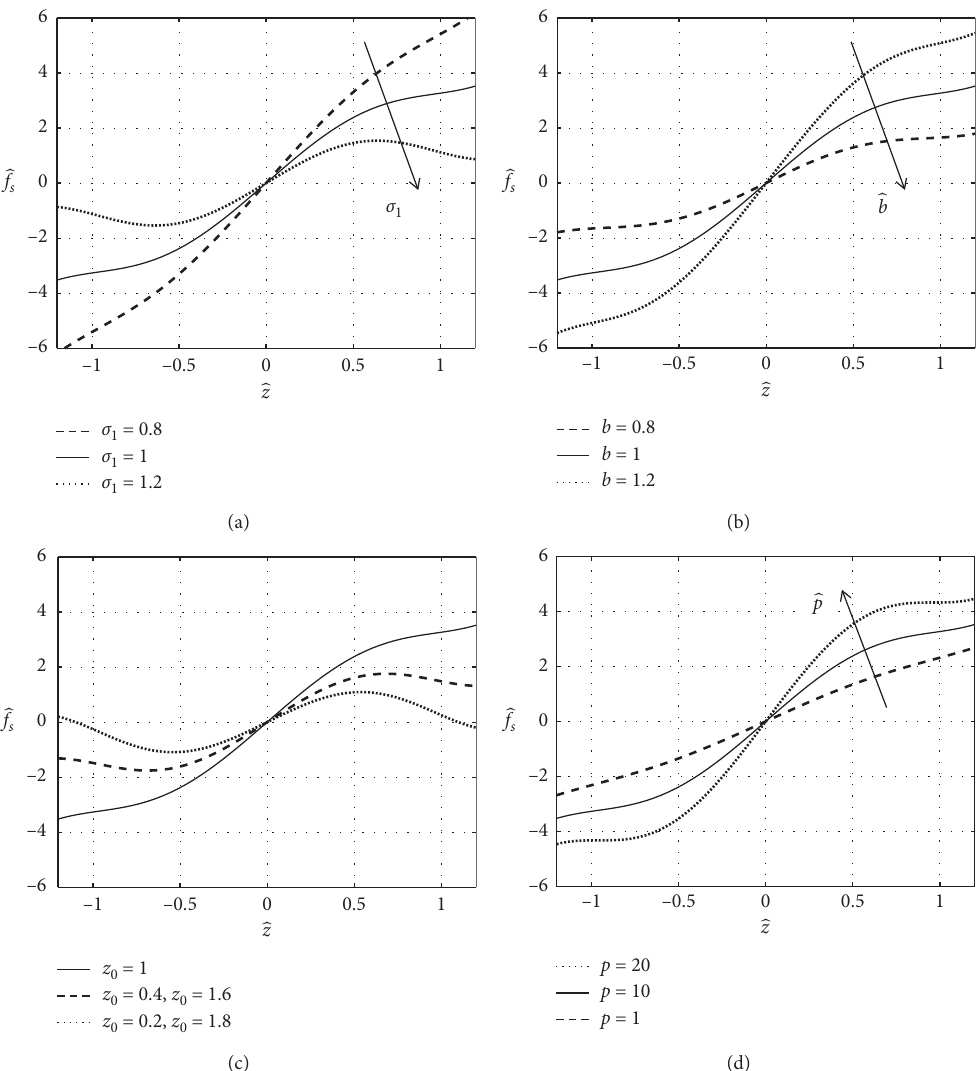
Figure 3: Symmetric force-deflection curve for different values of the system parameters (a–d), as indicated in the figure legends. The solid line is the common reference to all subfigures and corresponds to the case where σ